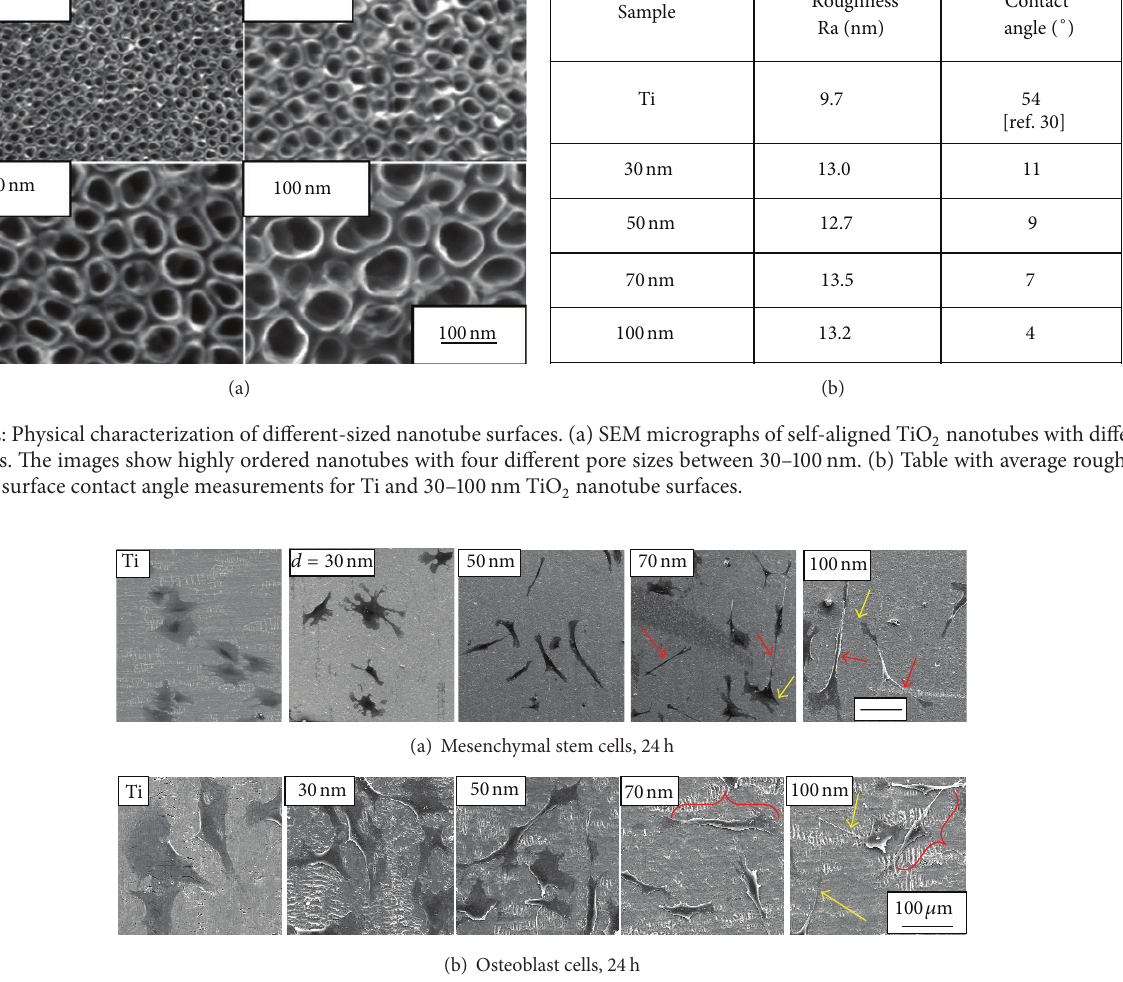
Figure 3: SEM micrographs of (a) human mesenchymal stem cells (hMSCs) and (b) osteoblast cells cultured on flat Ti and 30, 50, 70, and 100nm diameter TiO 2 nanotube surfaces after 24 h of culture (scale bar, 100 𝜇 m). Red arrows (a) and brackets (b) emphasize extraordinary cell elongation; yellow arrows indicate elongated leading edges of